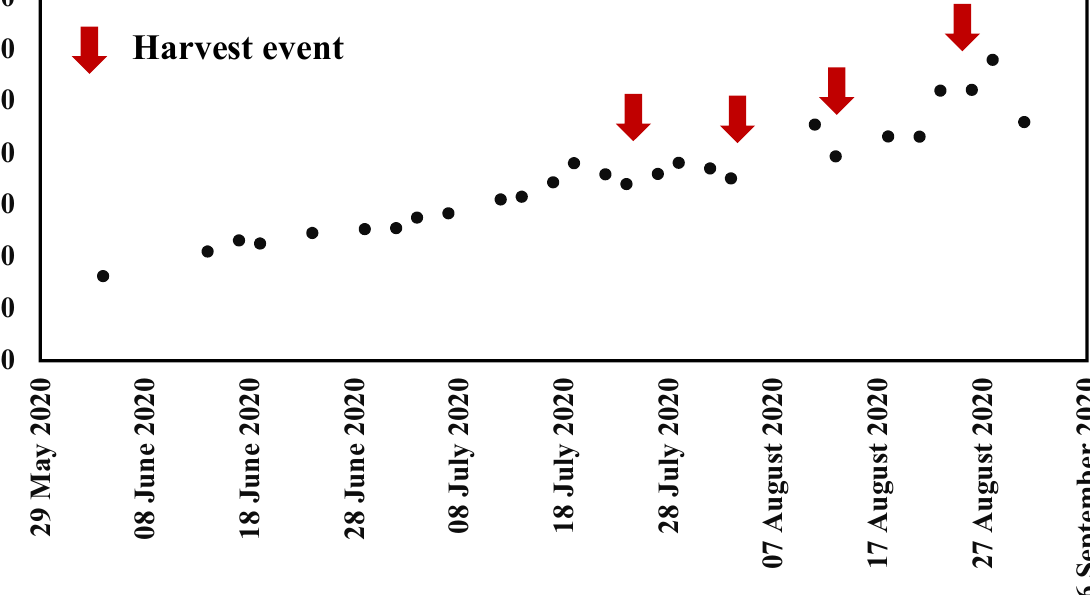
Figure 2. Normalized difference vegetation index ( NDVI ) values evolution during the summer season of 2020 over a pepper reference filed in the Kairouan Plain where red arrows indicate pepper harvest accompanied by hand weeding.